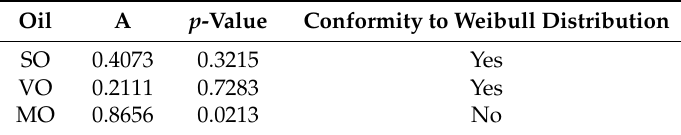
Table 6. Hypothesis test of conformity to Weibull distribution of oils alone in